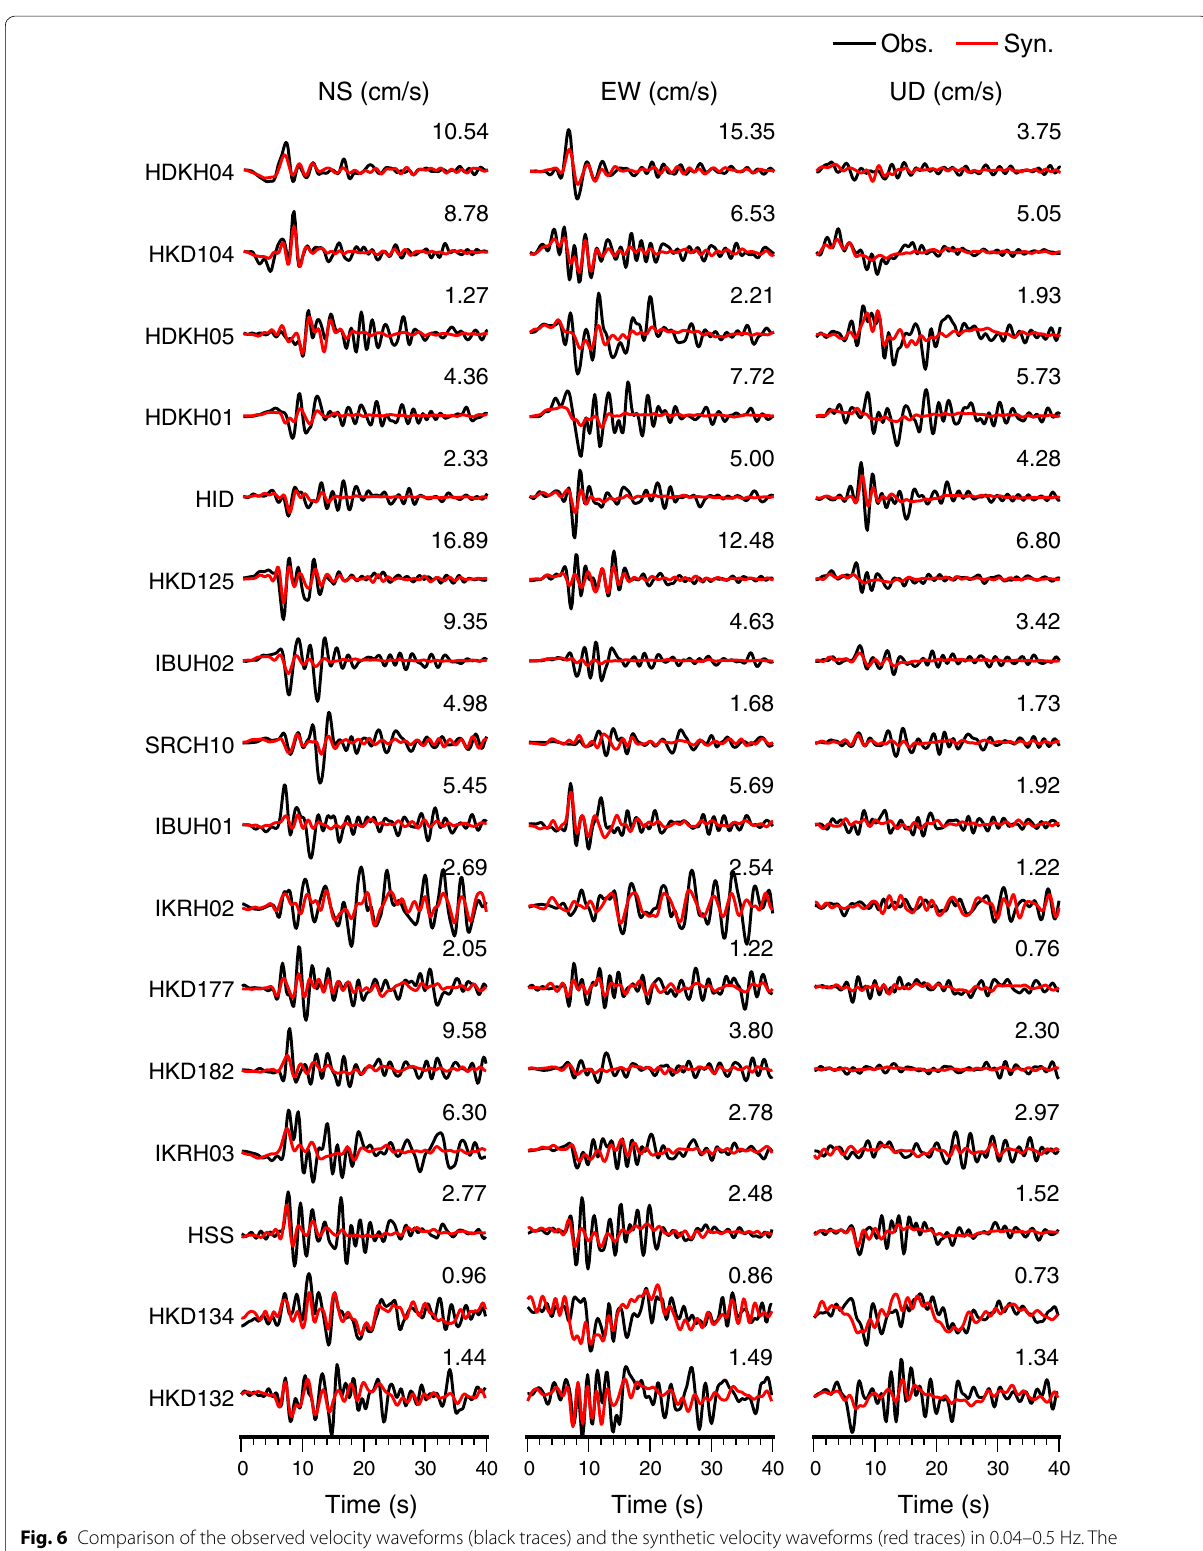
Fig. 6 Comparison of the observed velocity waveforms (black traces) and the synthetic velocity waveforms (red traces) in 0.04–0.5 Hz. The amplitudes were normalized by the maximum observed amplitude. The maximum observed amplitude of each component is shown above each trace in units of cm/s. NS north–south, EW east–west, UD